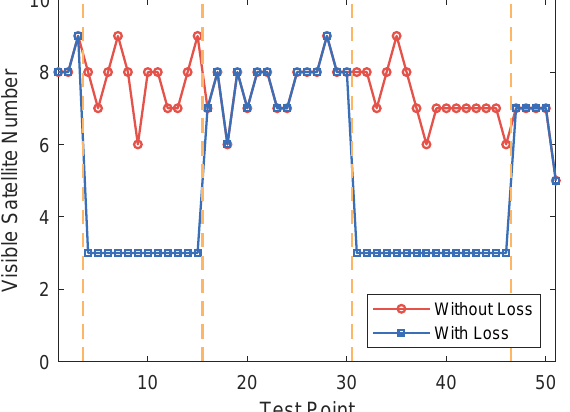
Figure 7. Number of available satellites at each test point at Site